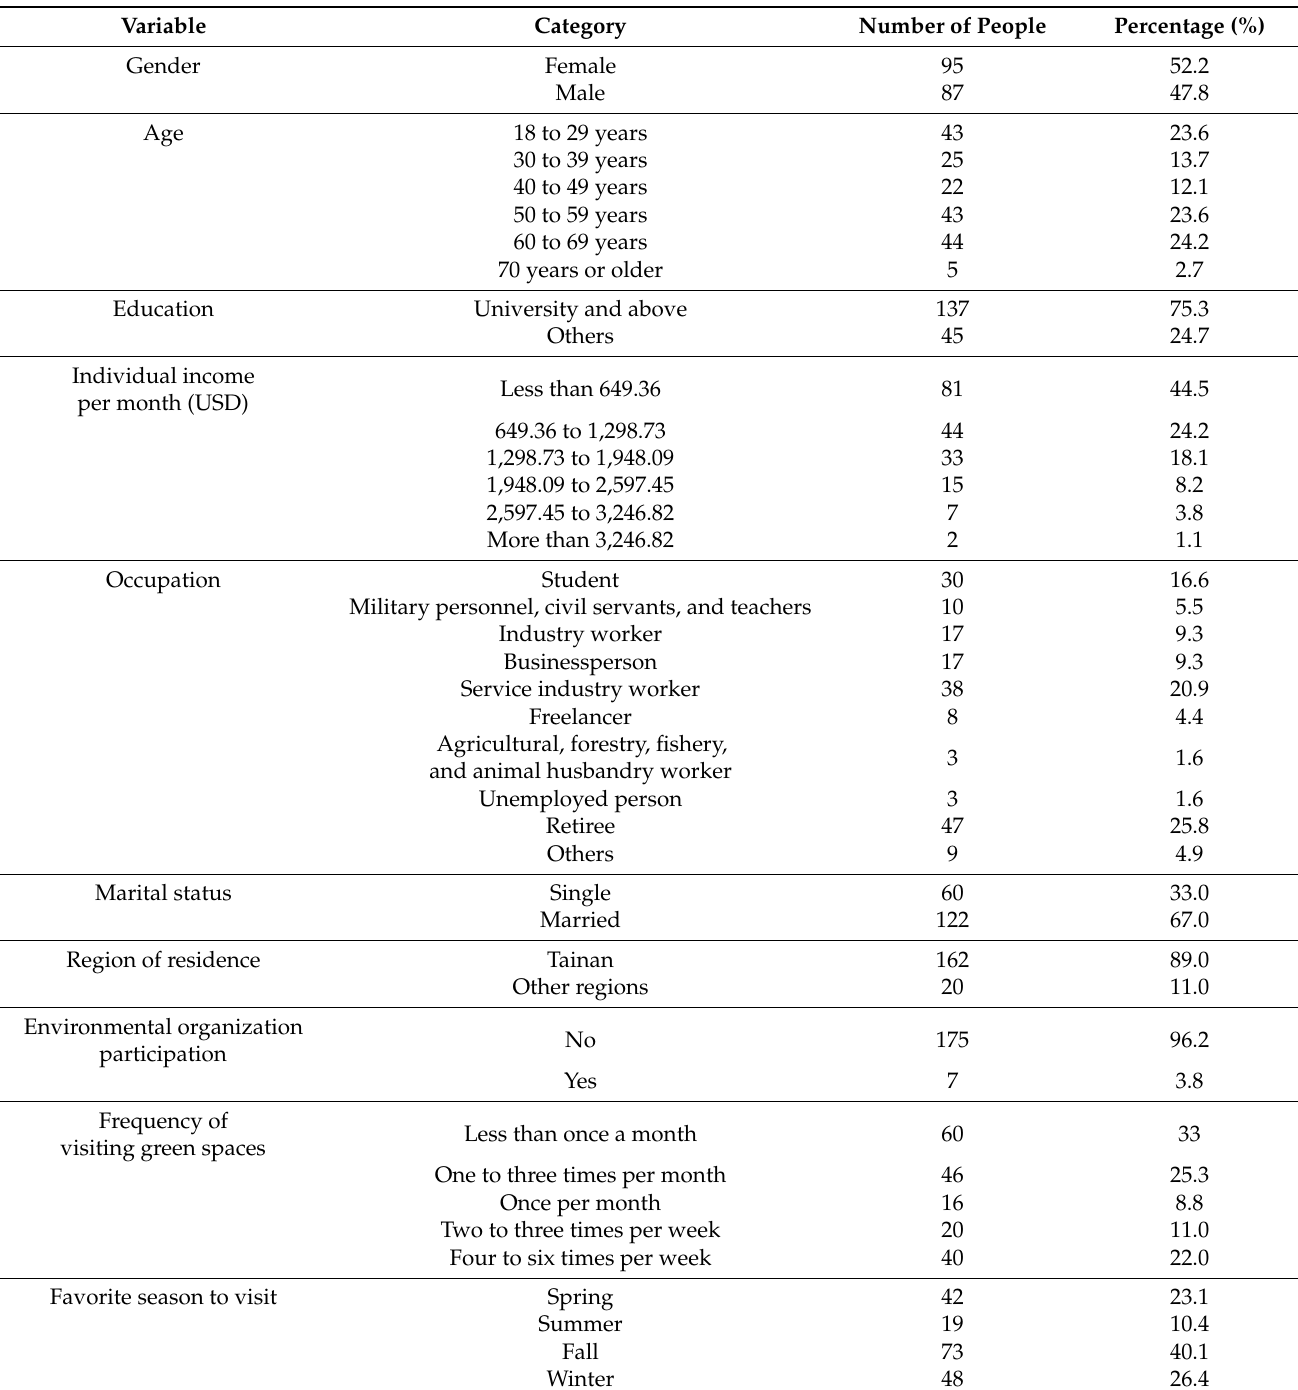
Table 3. Participants’ socioeconomic